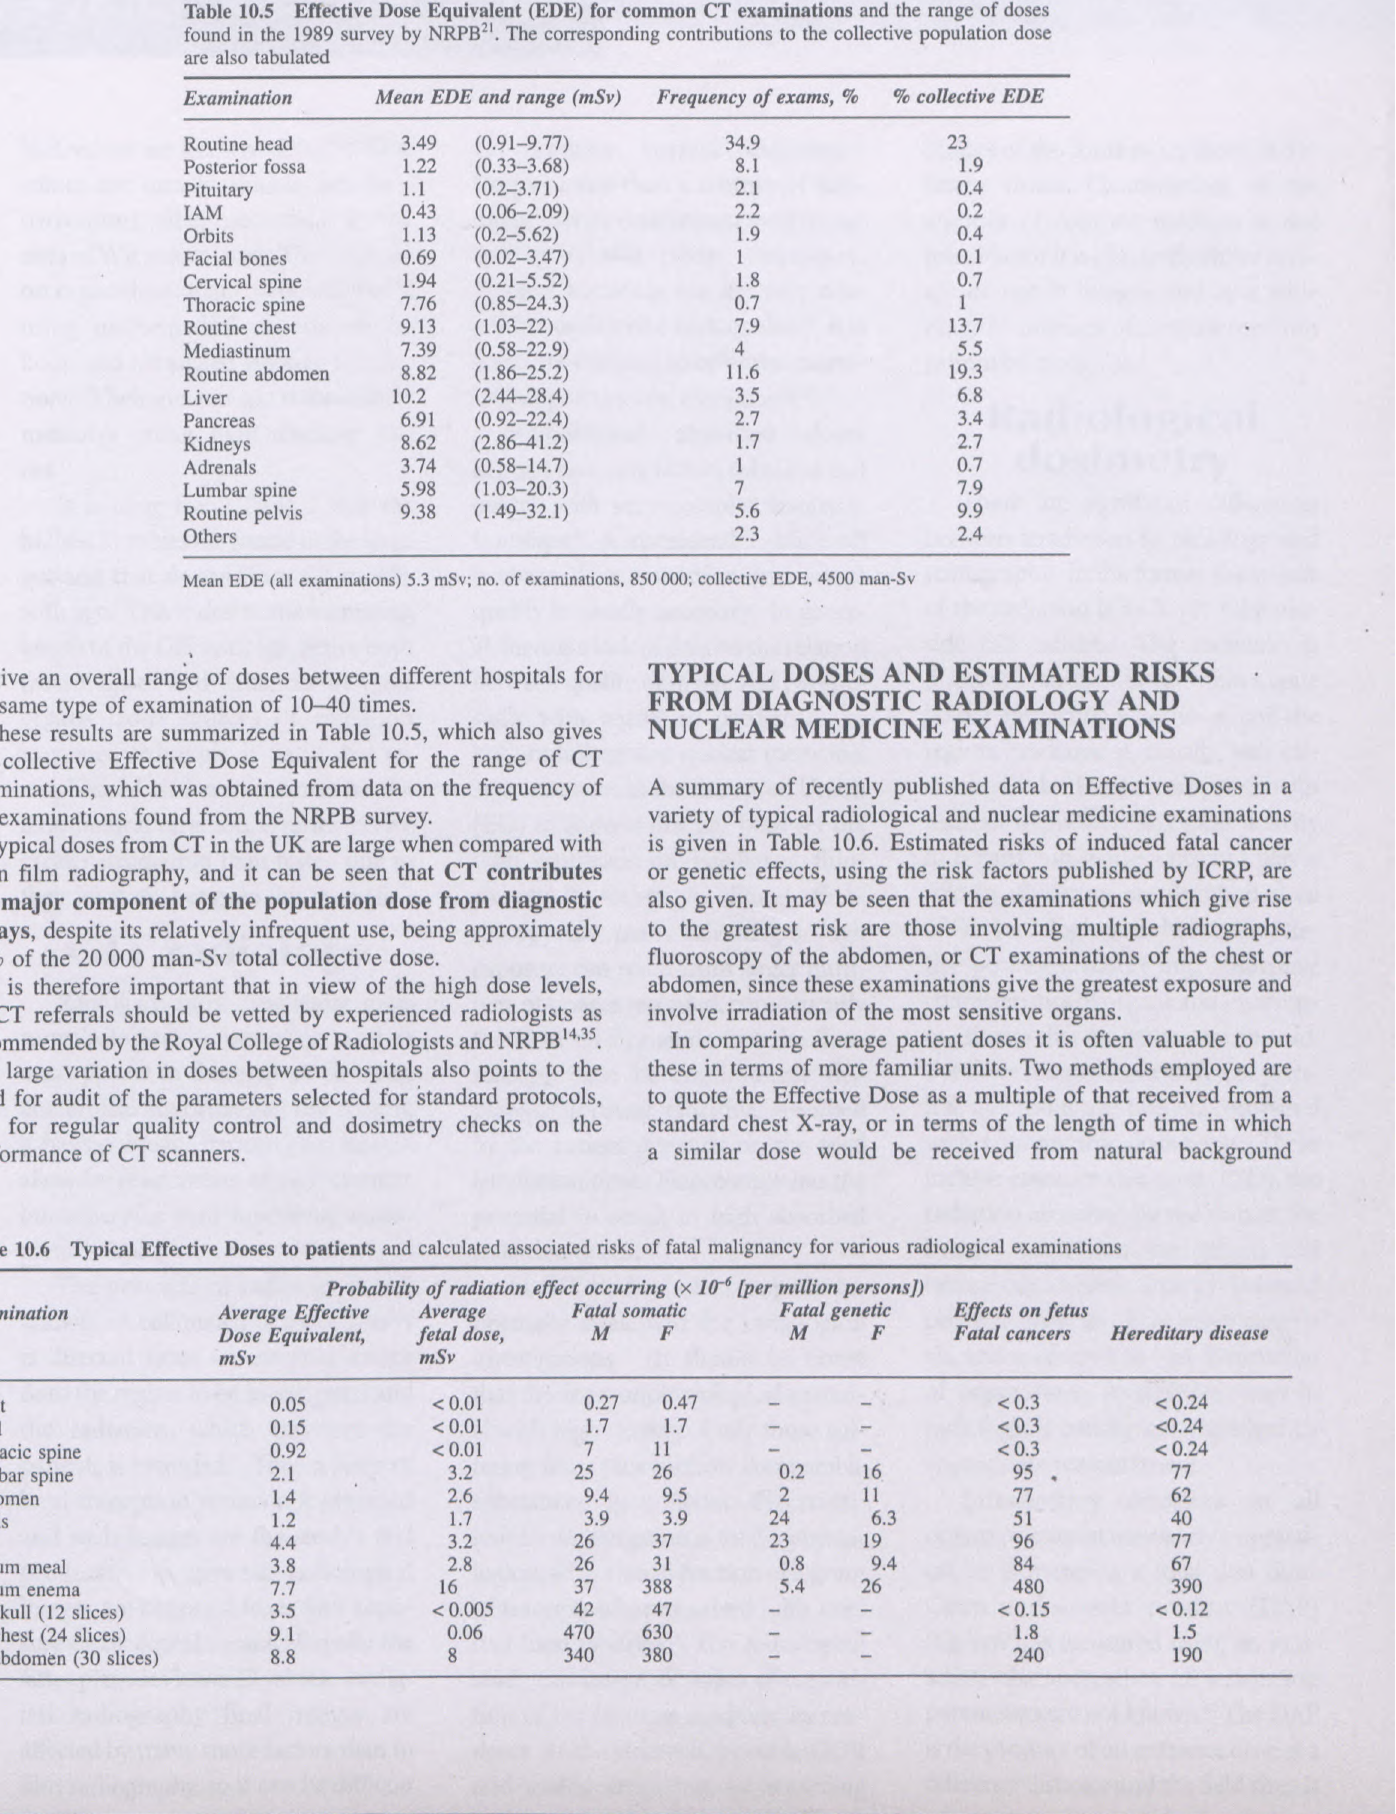
Table 10.5 Effective Dose Equivalent (EDE) for common CT examinations